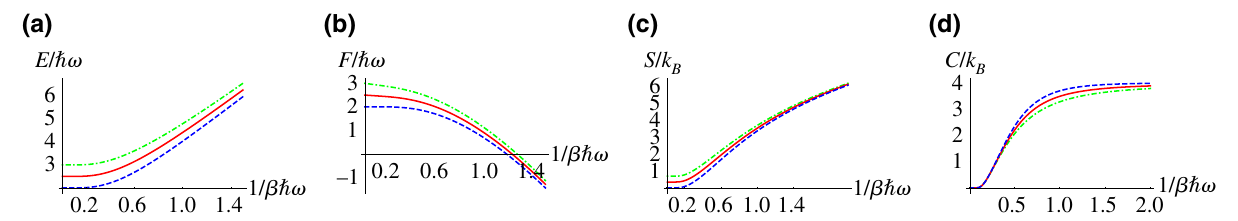
FIG. 4. Equilibrium (a) internal energy, (b) free energy, (c) entropy, and (d) heat capacity for two statistical anyons in two dimensions with anyonic phase corresponding to p B = 1 (blue, dashed), p B = 1 / 2 (red, solid), and p B = 0 (green, dot dashed).